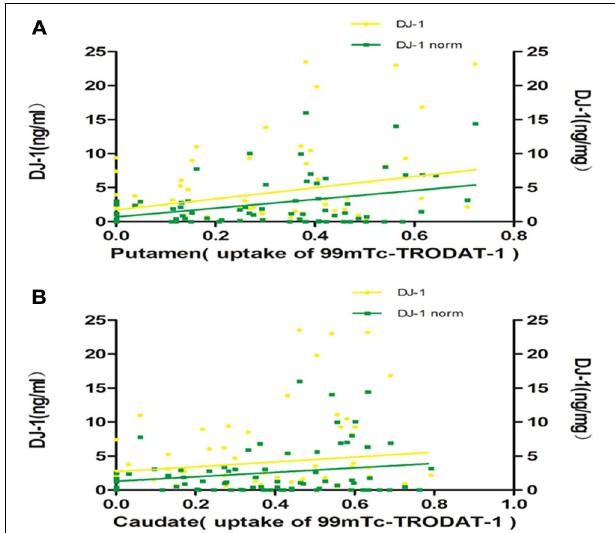
FIGURE 1 | Salivary DJ-1 levels and caudate, putamen uptake of 99m Tc-TRODAT-1. The uptake of 99m Tc-TRODAT-1 was measured by SPECT and DJ-1 levels in saliva were measured by Luminex assay in 74 PD patients. (A) Non-parametric spearman’s correlation analysis revealed that salivary DJ-1 levels were weakly associated with putamen nucleus uptake of 99m Tc-TRODAT-1 in PD patients ( p = 0 . 20, R = 0.151, p = 0 . 026, R = 0.258 when normalized). (B) Statistical analysis revealed that salivary DJ-1 levels did not correlate with caudate nucleus uptake of 99m Tc-TRODAT-1 in PD patients whether normalized ( p = 0 . 72, R = 0.043) or not ( p = 0 . 73, R = − 0 . 041).